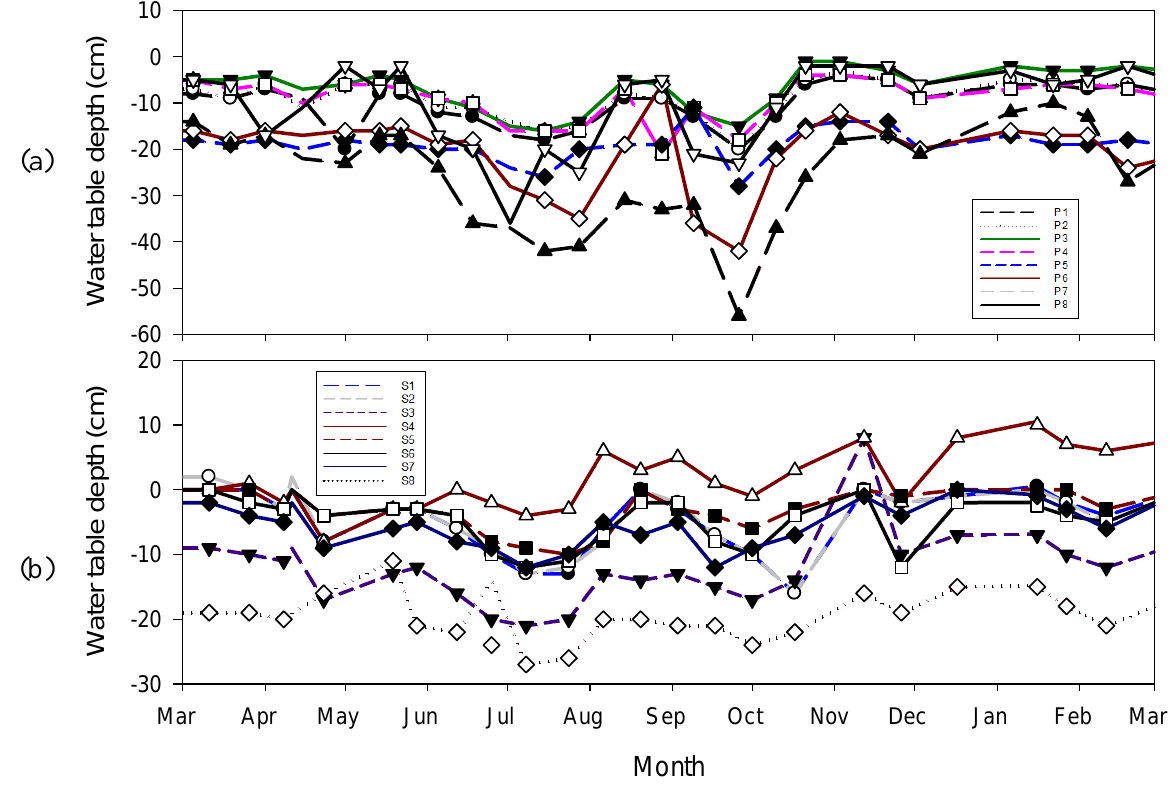
Figure 4. Interpolated water table depths (cm) in all study plots at (a) Pollagoona and (b) Scohaboy from March 2014 to February 2015. Markers show observations while lines show interpolated